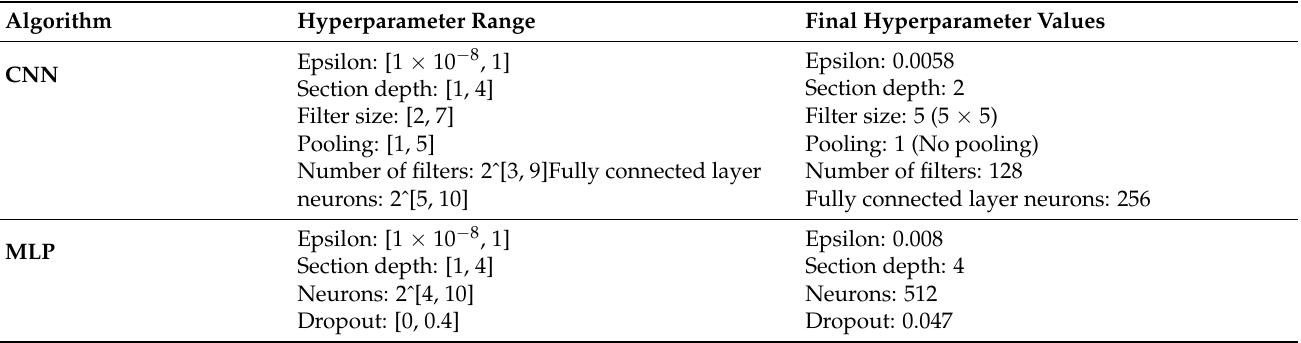
Table 3. Neural Network Hyperparameter Values Used in the Final Tuned Gender